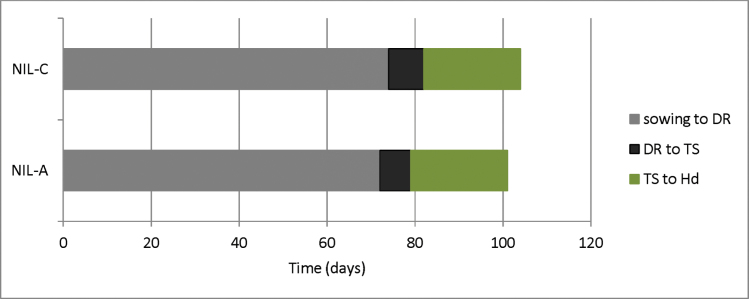
Duration of developmental phases of NIL-A (carrying the Avalon allele) and NIL-C (carrying the Cadenza allele). Developmental phases were divided into three phases: from sowing to double ridge (DR) in grey, from DR to terminal spikelet (TS) in black, and from TS to heading (Hd) in green. Differences between NIL-A and NIL-C were significant at P<0.001 for sowing to DR and DR to TS, but not for TS to Hd.